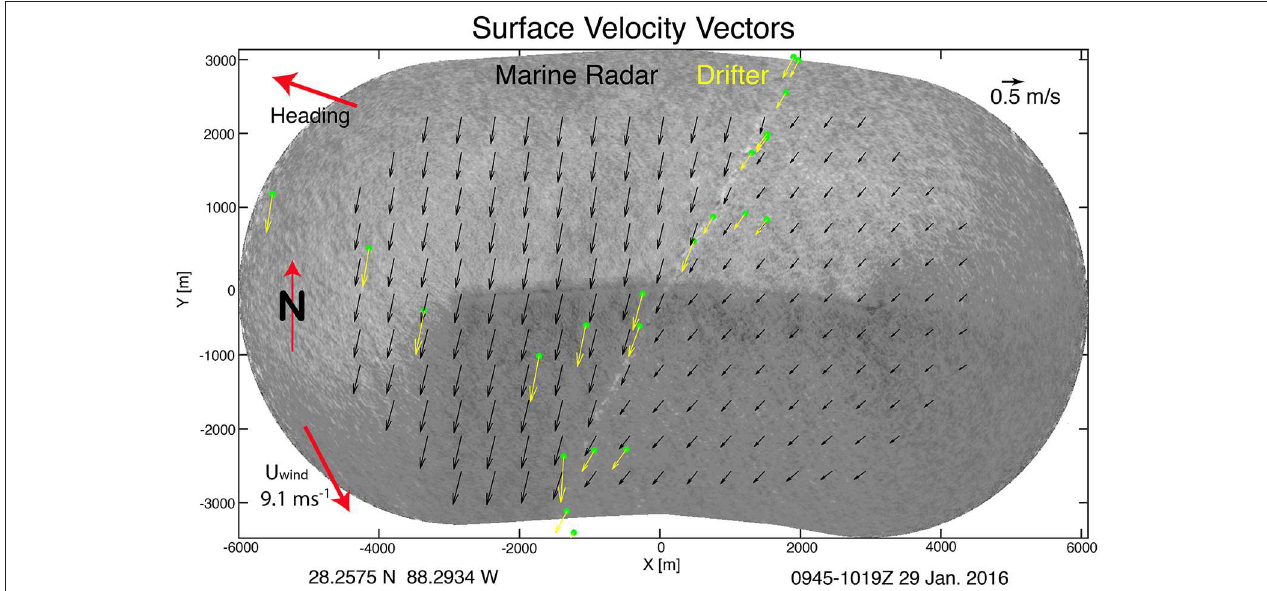
FIGURE 4 | Ship-mounted marine radar measurements of a submesoscale front. Grayscale indicates the radar backscatter intensity. Black arrows show surface velocity measured by the radar. Green dots indicate the positions of CARTHE drifters and yellow arrows show their velocities. The LASER drifter data and radar data shown here are available at D’Asaro et al. (2017) and Lund and Haus (2018),